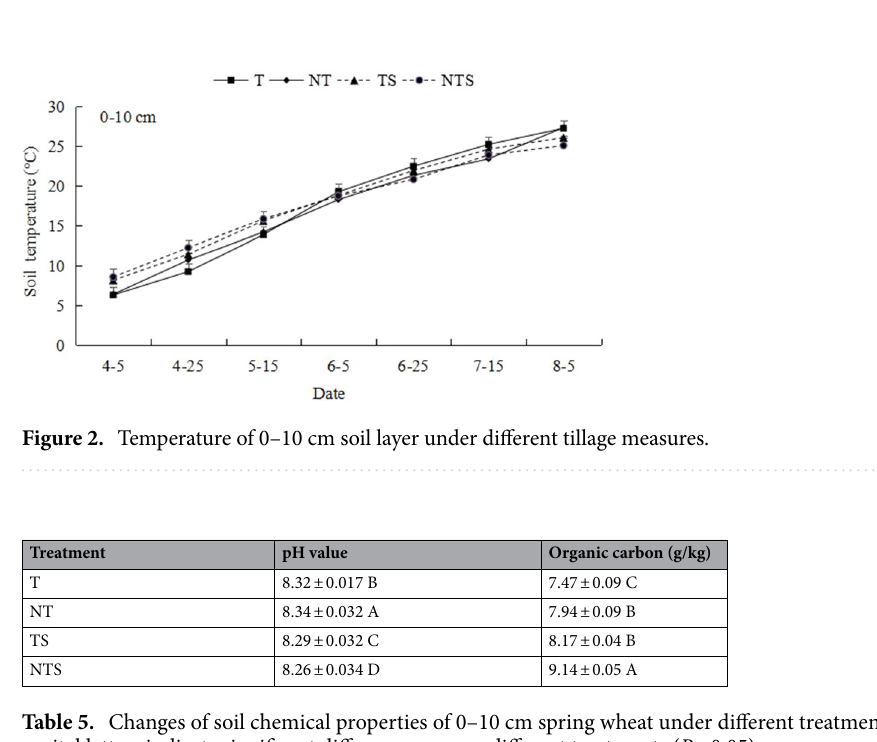
Table 4. Changes of soil physical properties of 0-10 cm spring wheat under different treatments. Different capital letters indicate significant differences among different treatments ( P < 0.05).